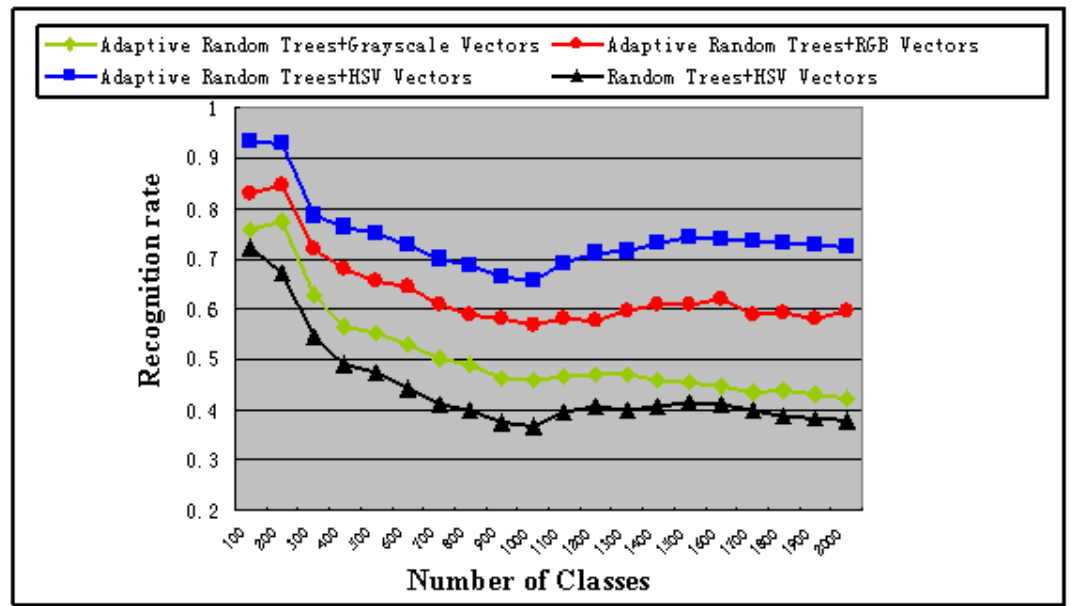
Figure 1. Comparison of recognition rates of different methods.